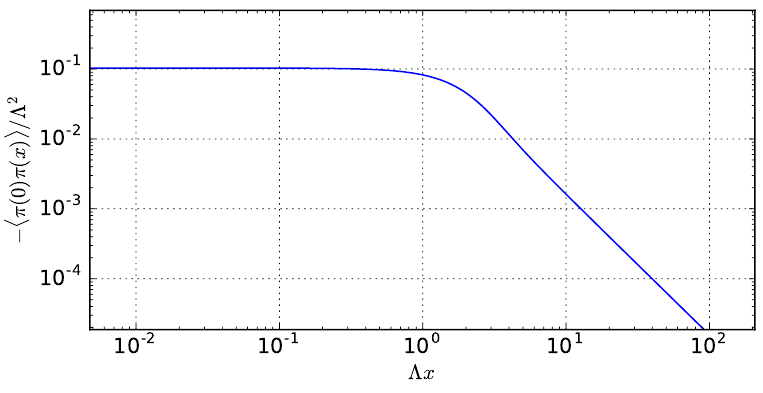
Figure 5 . h (cid:25) (0) (cid:25) ( x ) i correlator computed for a cMERA de(cid:12)ned by 3.12. Notice the existence of two clearly di(cid:11)erent regimes delimited by (cid:3) x (cid:24) 1. These results were obtained with an IR regulator with " = 10 (cid:0) 6